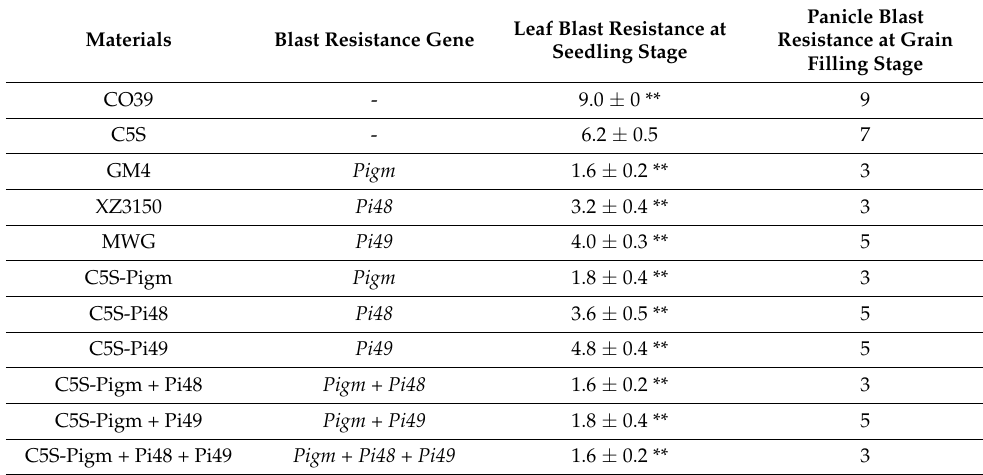
Table 2. Blast resistance of C5S and improved lines.